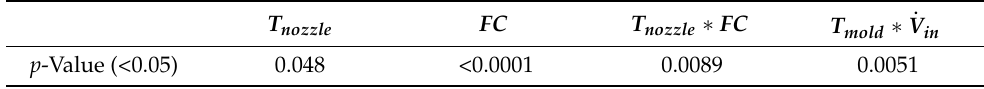
T nozzle FC T nozzle ∗ FC T